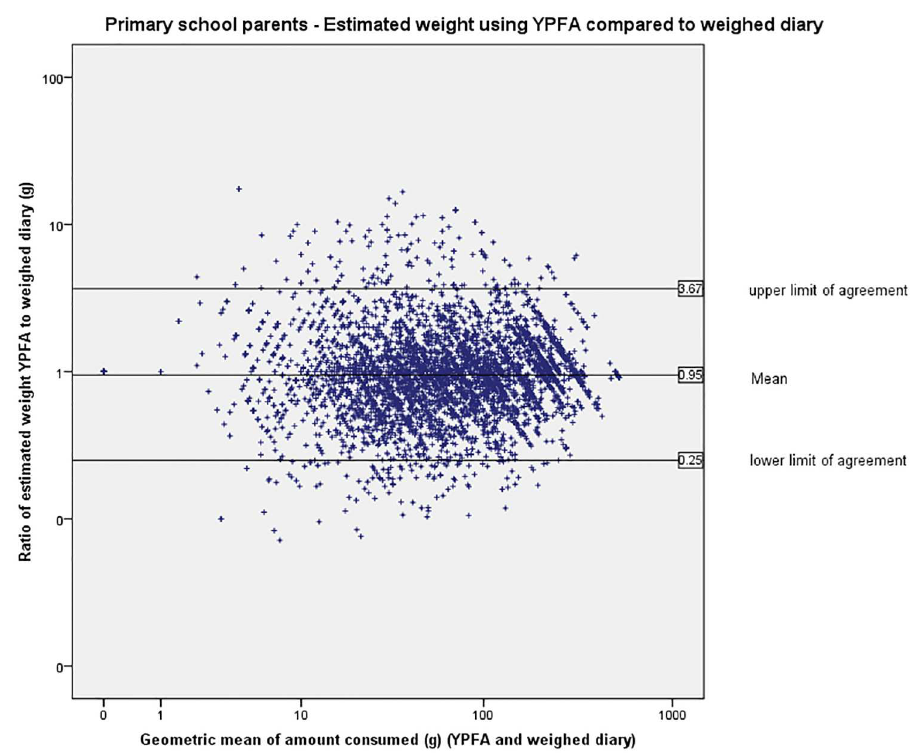
Fig 5. Primary school parents—Bland-Altman plot showing estimated weight using YPFA compared to weighed